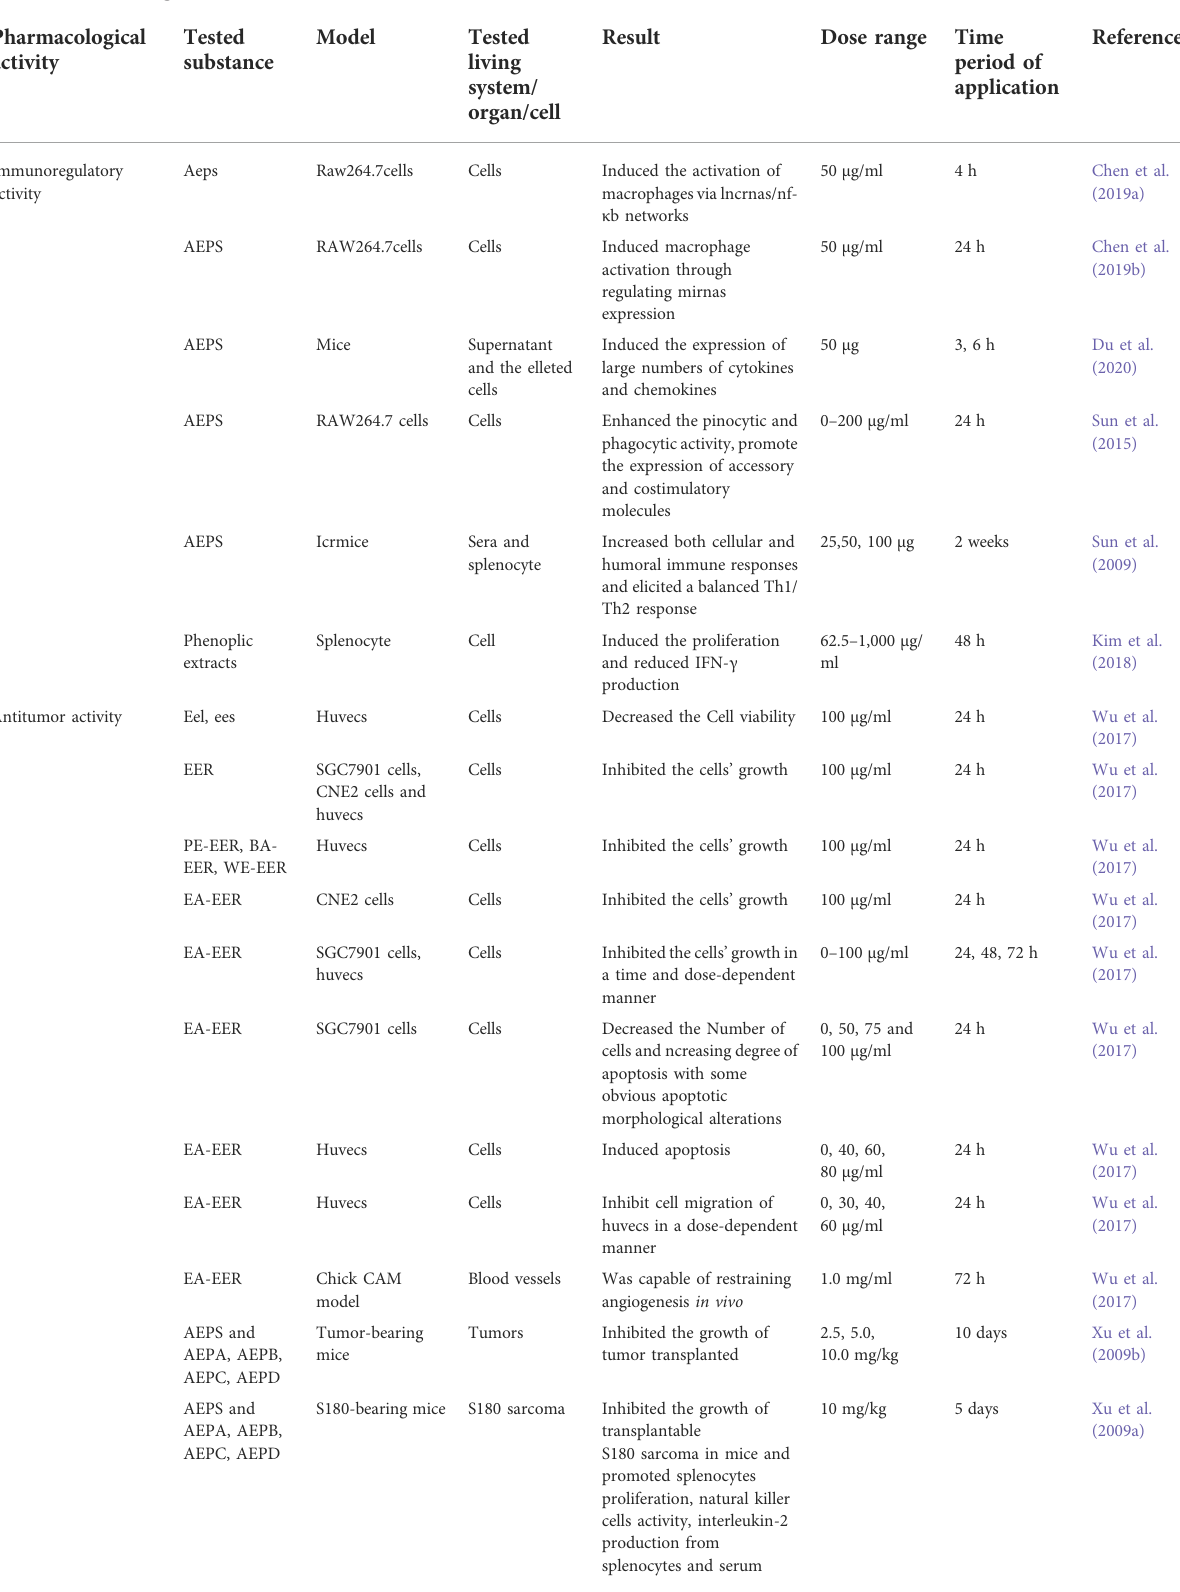
TABLE 2 Pharmacological activities of Actinidia eriantha